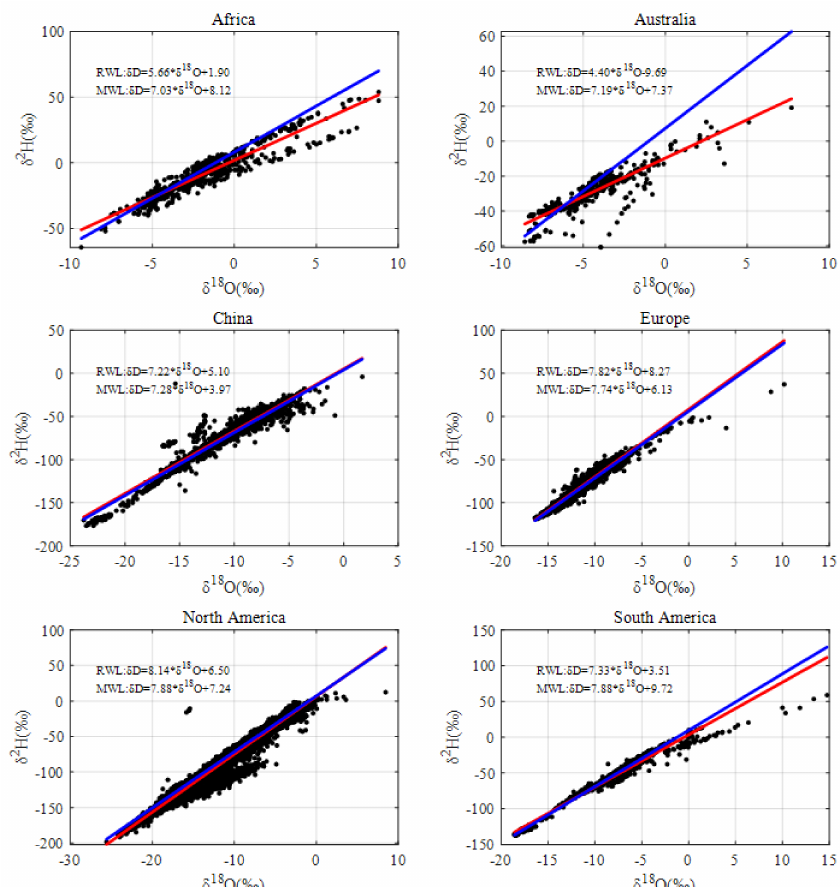
Figure 10. Relationship between δ 18 O and δ 2 H in river water in six regions. Black points represent the δ 2 H- δ 18 O data points. Lines in red and blue represent the river and meteoric water line (RWL and MWL) of the regions,